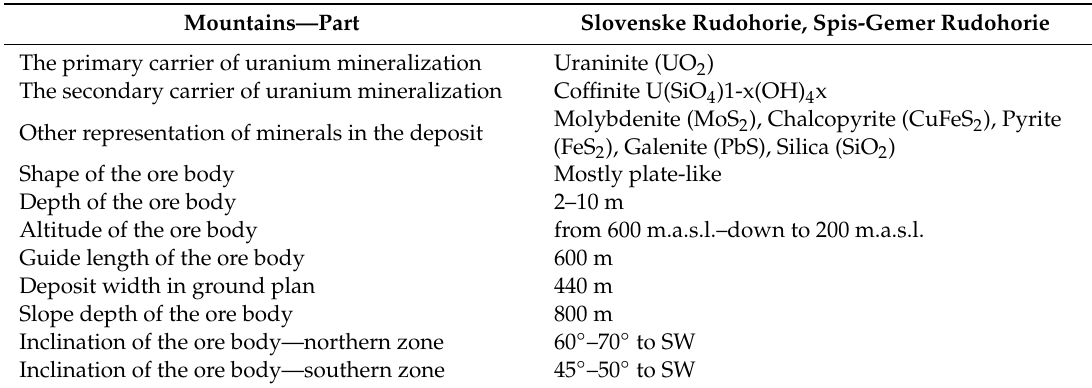
Table 2. Mining—geological parameters of the deposit of Kuriskova [62].